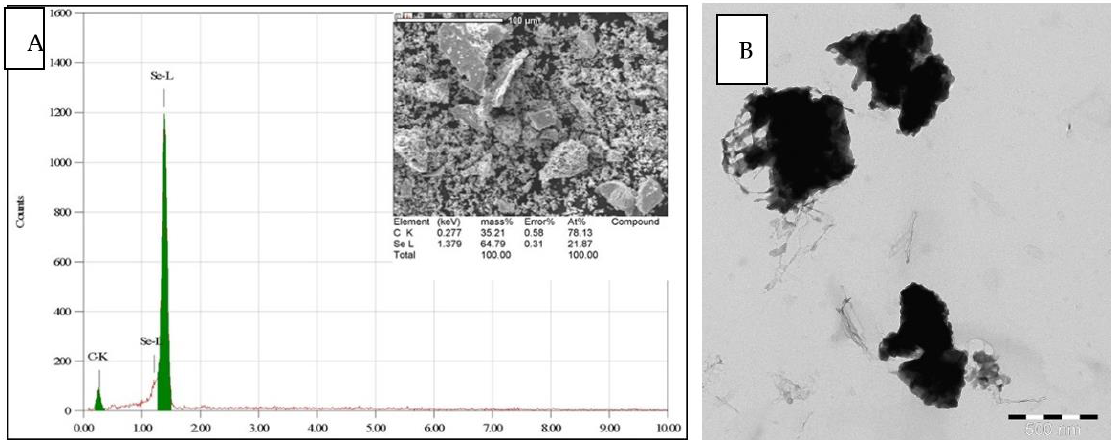
Figure 2. ( A ) EDS elemental analysis of stabilized nano-selenium. ( B ) The TEM image of nano- selenium.